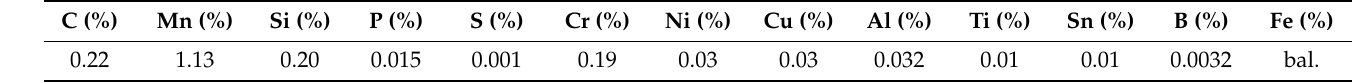
Table 1. Chemical composition of 22MnB5 measured by GDOES in weight